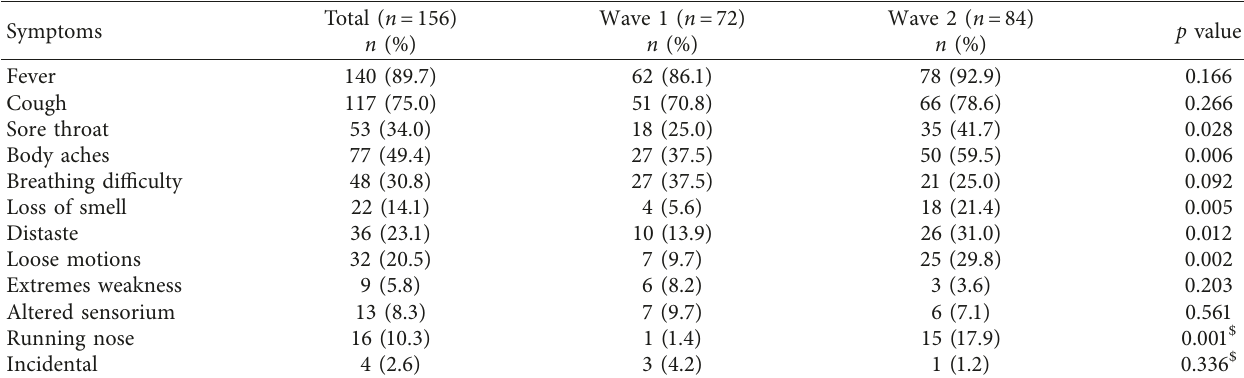
Table 2: COVID-19 related symptoms in KTRs in both